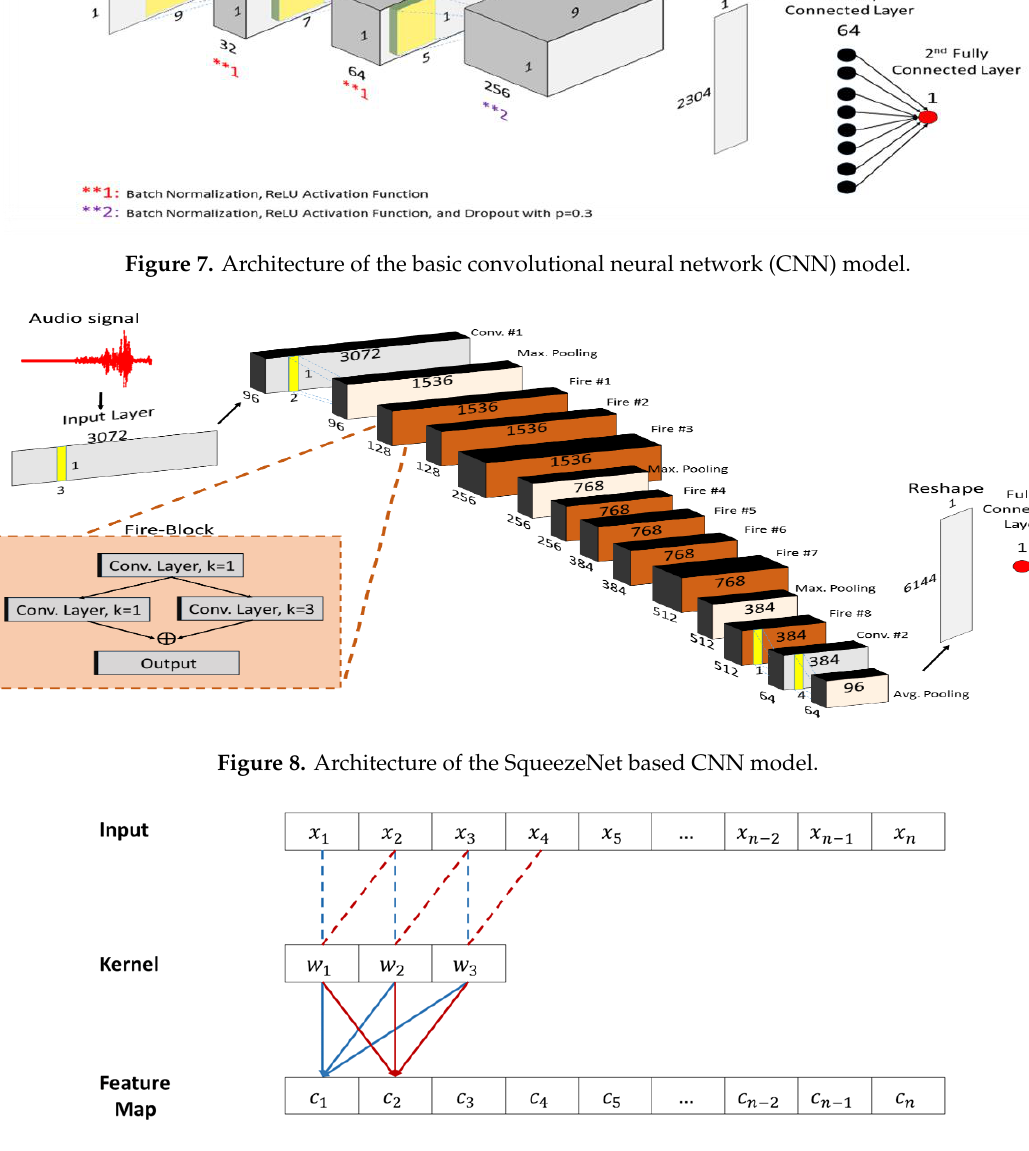
Figure 7. Architecture of the basic convolutional neural network (CNN) model.